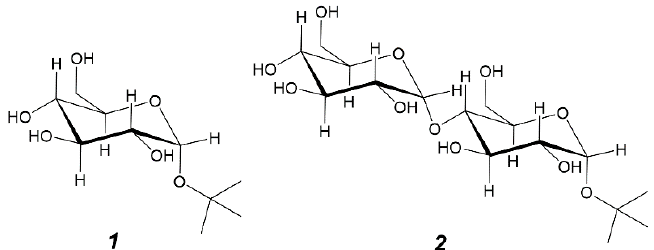
Figure 2. Chemical structure of the synthesized glycosides: ( 1 ) tert -butyl-O- α -D-glucopyranoside and ( 2 ) tert -butyl-O- α -D-maltoside.